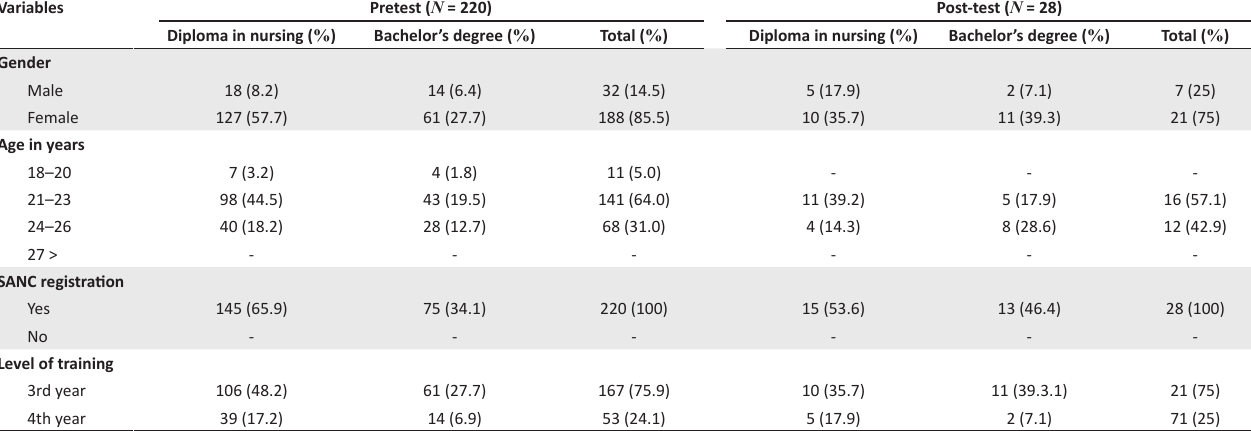
TABLE 1: Pretest-post-test biographical data. Variables